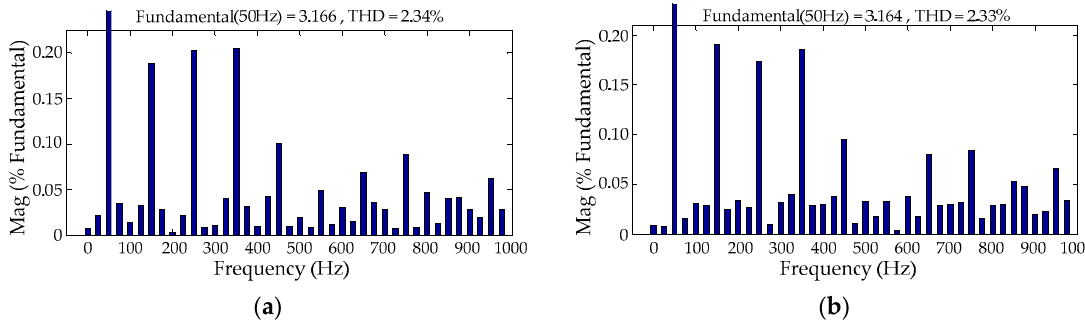
Figure 29. The harmonic spectrum results of power quality improvement under decentralized control and centralized control ( a ) stage 2 in decentralized control; ( b ) stage 2 in centralized control.